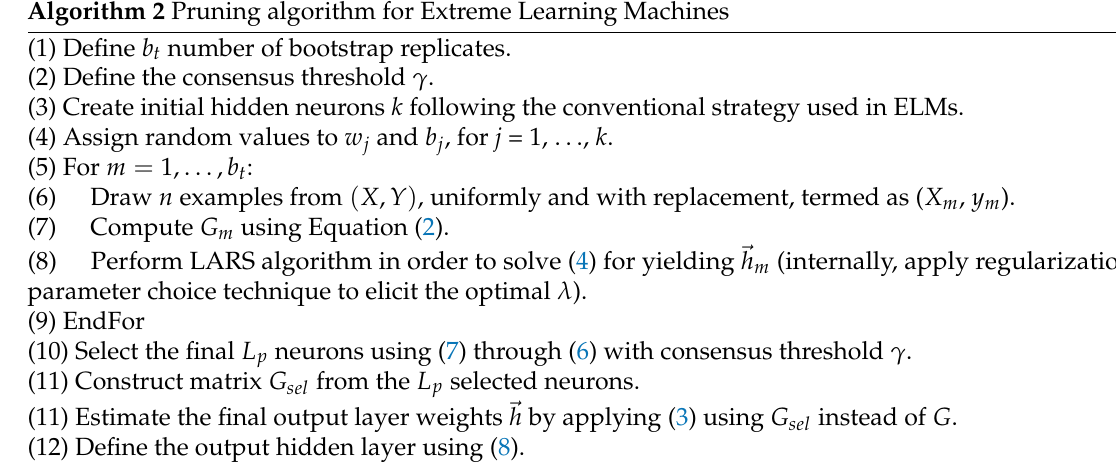
Algorithm 2 Pruning algorithm for Extreme Learning